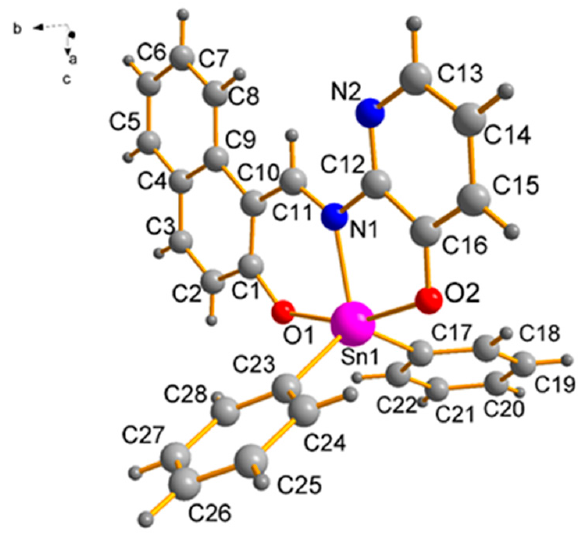
Figure 1. Molecular structure of compound 1c .